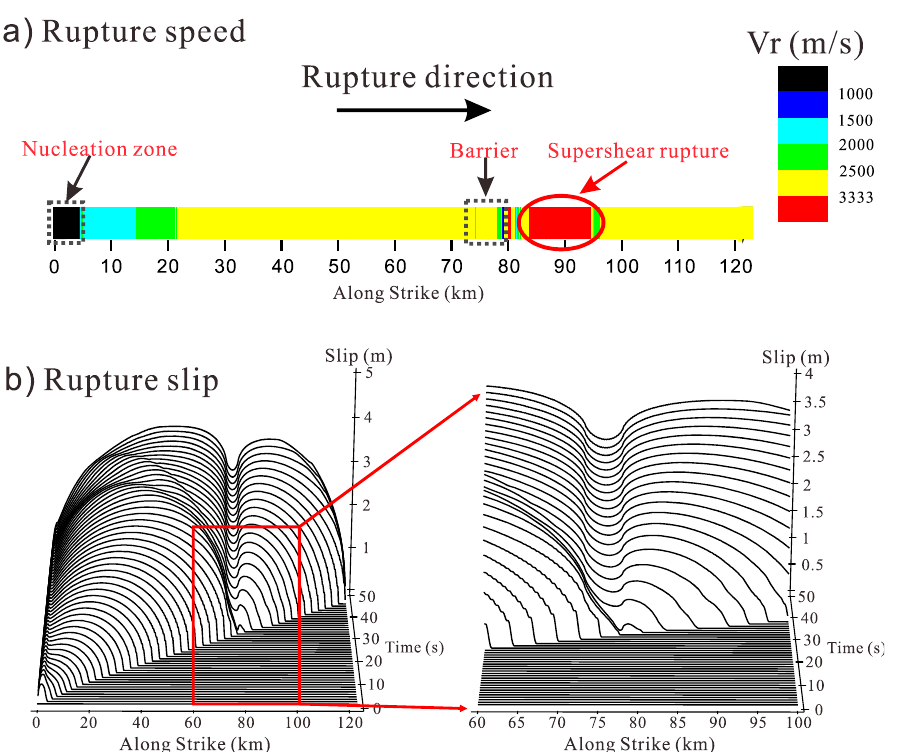
Figure 2. ( a ) Distribution diagram of the rupture speed on the fault surface of Weng’s model (SW for short). ( b ) Distribution diagram of the slip along the interface over time.